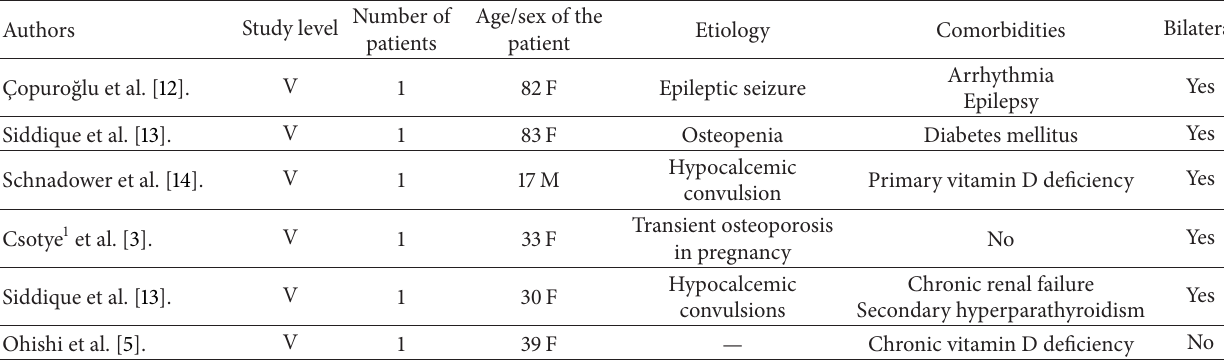
Table 1: Reported cases of spontaneous femoral